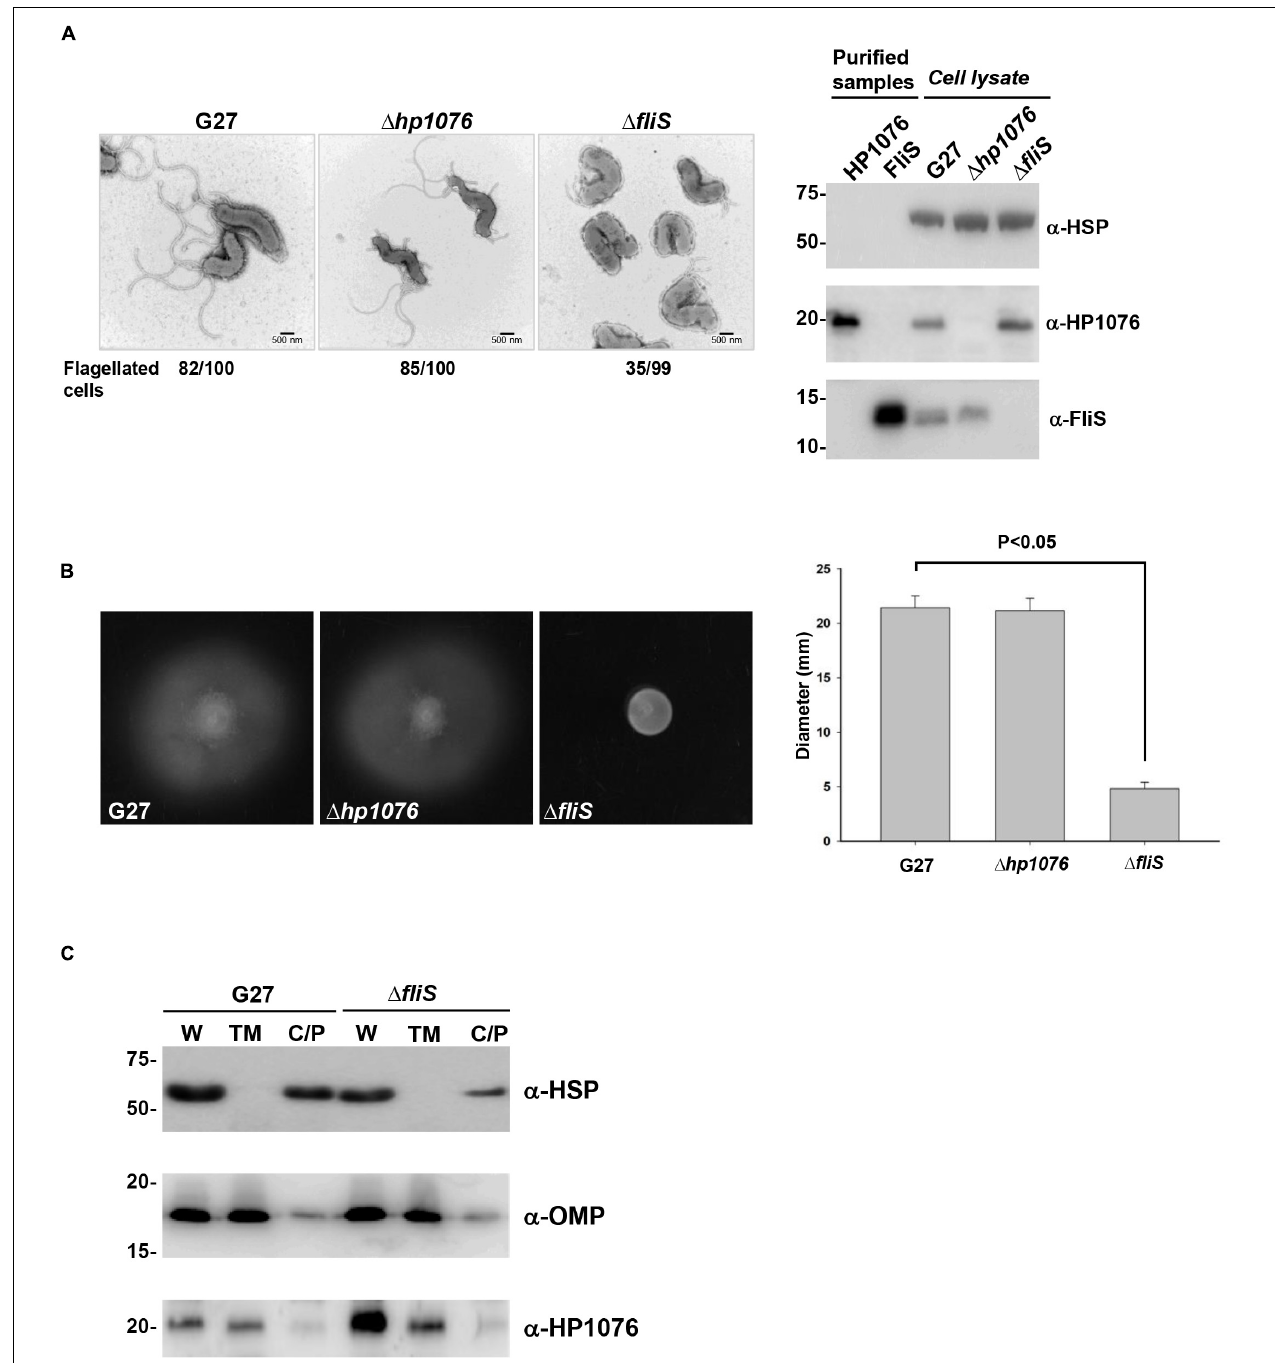
FIGURE 5 | H. pylori G27 hp1076 -null and fliS -null strains were constructed and examined. (A) (Left) Flagellation in the H. pylori G27, hp1076 -null and fliS -null strains was examined by negative staining and transmission electron microscopy. Scale bar = 500 nm. (Right) The G27 hp1076 -null and fliS -null strains were validated by immunoblotting. (B) Soft agar motility assay. (Left) Representative images of the diameters of wild-type, hp1076 -null and fliS -null colonies measured after 3–4 days. (Right) The average colony diameter of the fliS -null strain was 4.83 ± 0.58 mm ( n = 12), and was significantly smaller than the diameters of the wild-type (21.42 ± 1.08 mm, n = 12) and hp1076 -null strains (21.17 ± 1.11 mm, n = 12). (C) Cell fractionation analysis of the H. pylori G27 WT and fliS -null strains. The whole cell fraction (W), total membrane fraction (TM) and cytosolic/periplasmic fraction (C/P) were blotted using specific antibodies. Heat shock protein (HSP) was used as the marker for the cytosolic/periplasmic fraction, and outer membrane protein (OMP) was used as the marker for the total membrane fraction. HP1076 was mainly detected in the membrane fraction.